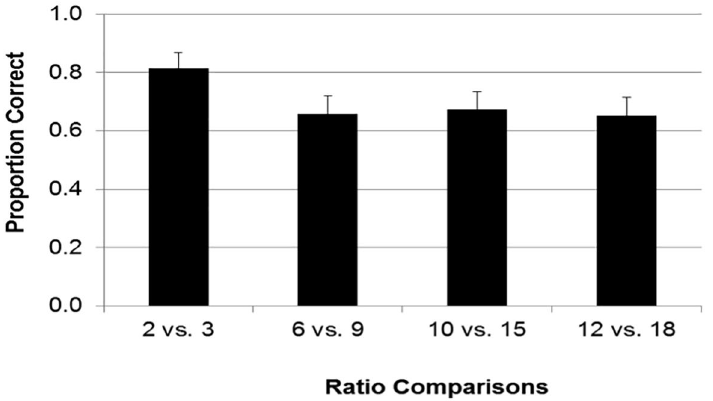
Figure 4. Proportion correct on small and each of the large numerosity comparisons in Experiment 2. Error bars represent standard error of the